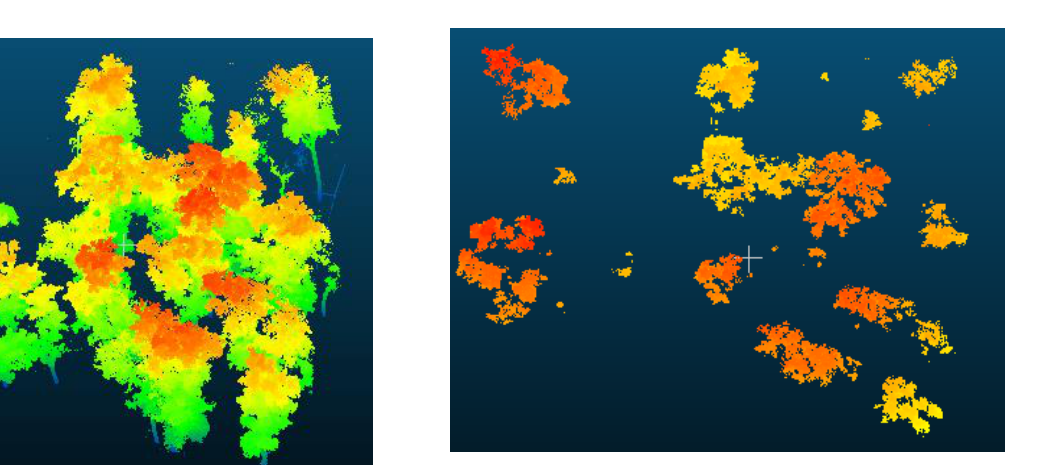
Figure 12.The extraction of non-ground seed points using CSF in the measured area by setting cloth resolution of 0.5